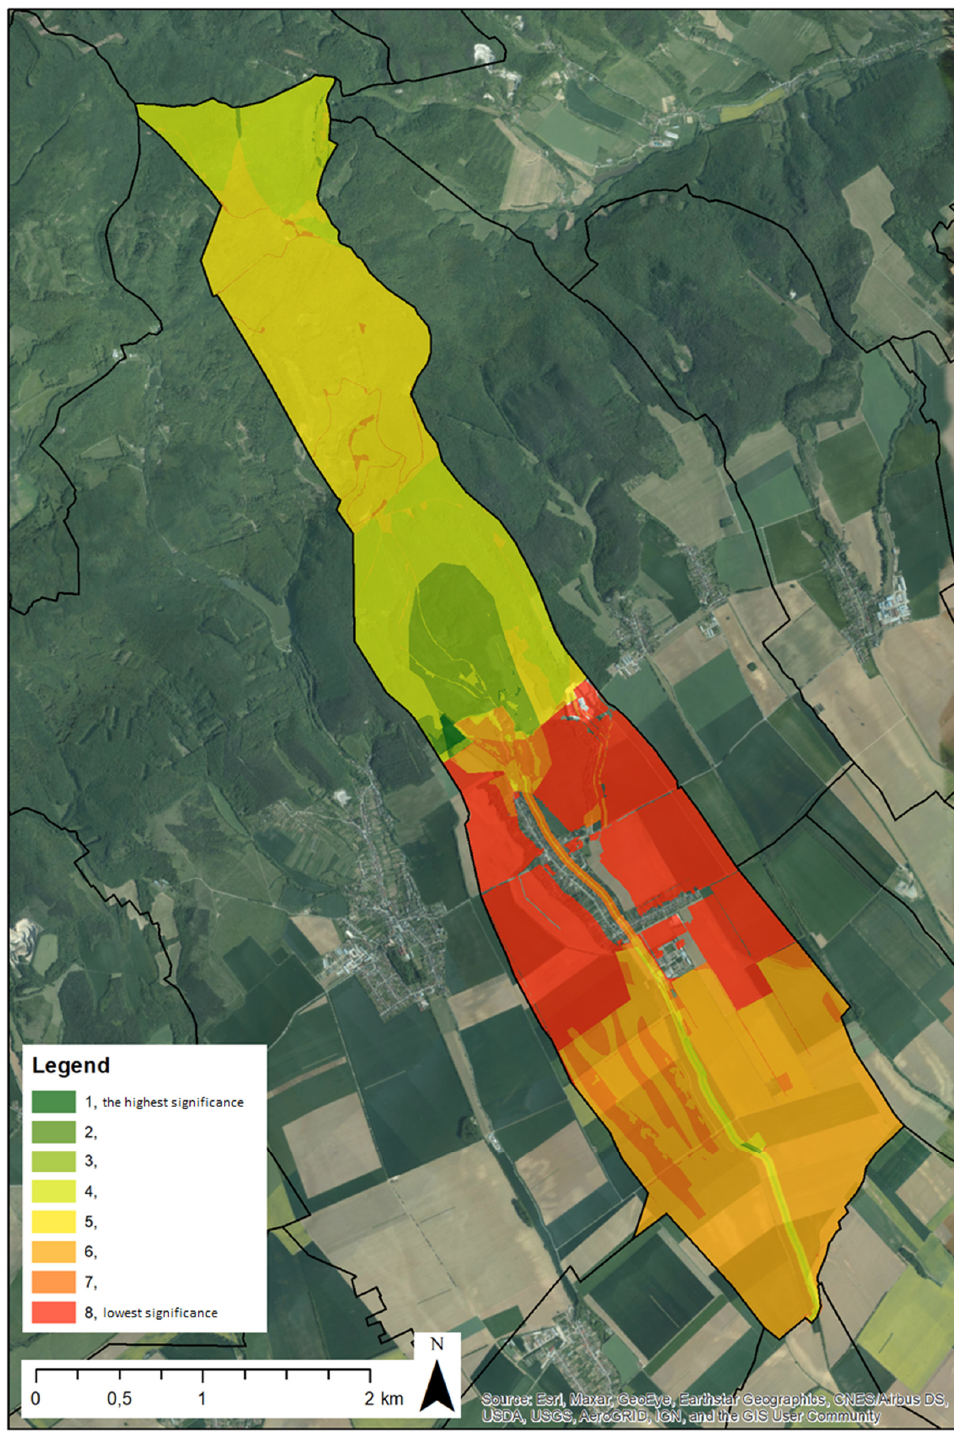
Figure 9. Landscape ecological significance. Author: Moyzeová, M. Technical processing: Rákayová, R.